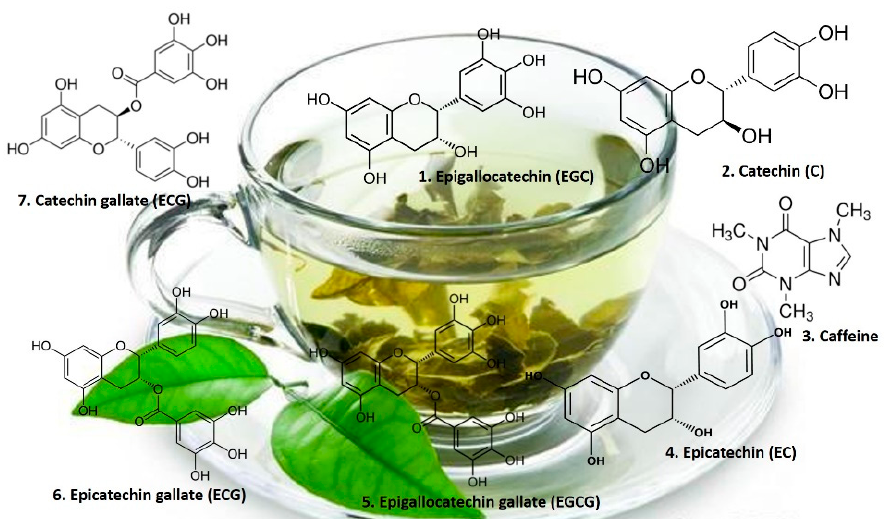
Figure 2. Chemical structures of catechins present in green tea.